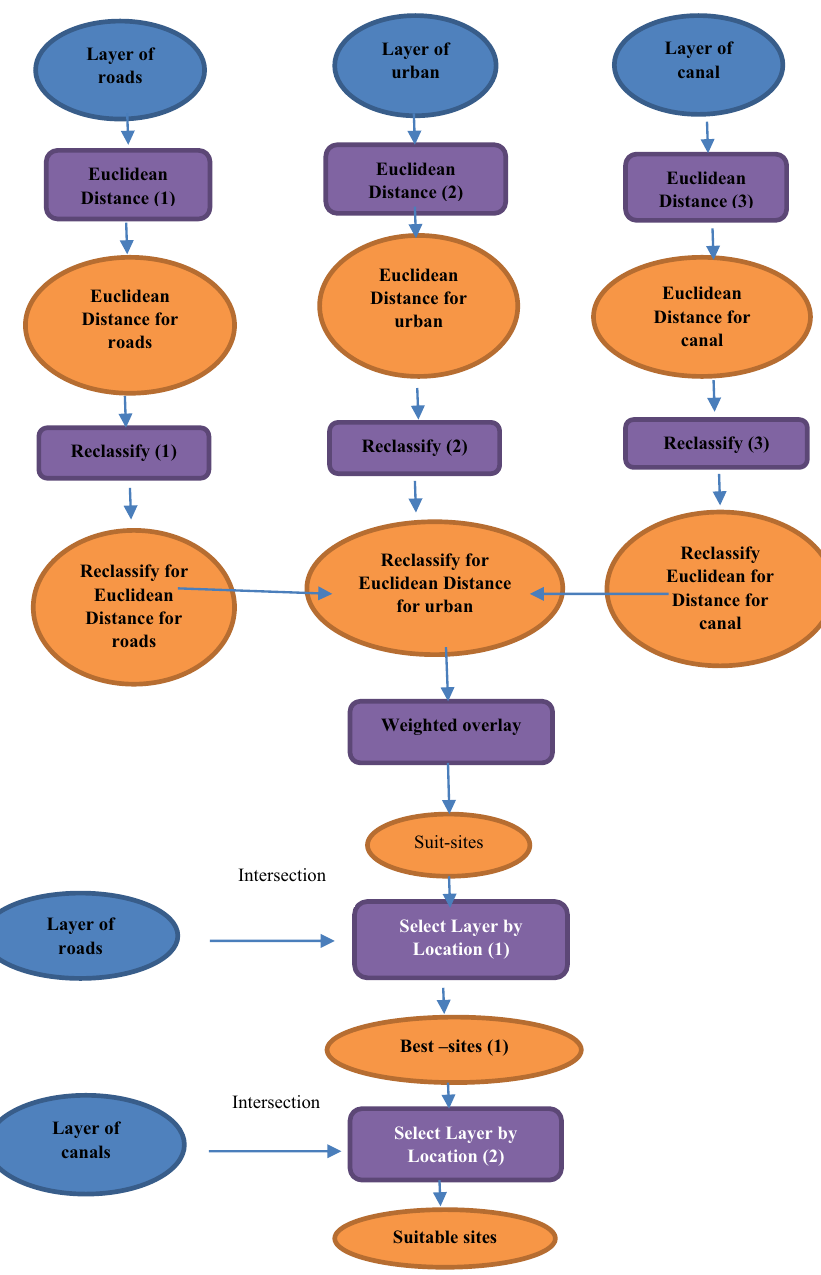
Figure 4. Short form for modeling to select suitable sites to assembly rice